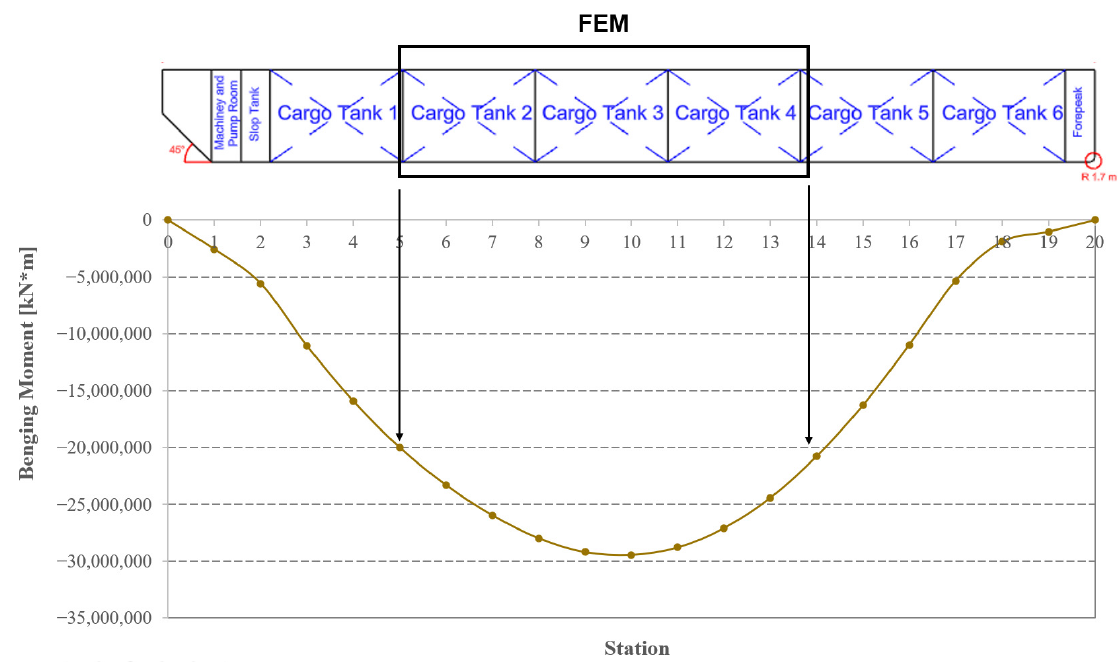
Figure 8. Boundary loads to be applied.